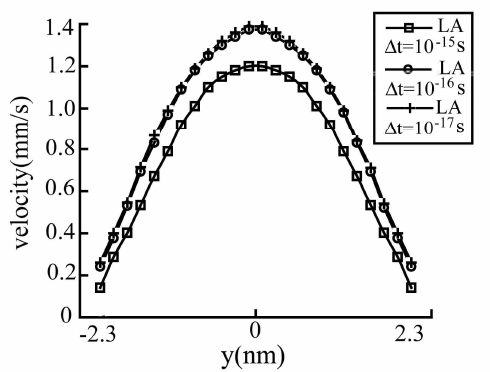
Figure 6 . Comparison of simulation results with different ∆ t (LA Method). Low flow velocity simulations of case 2. The vertical coordinate is the flow velocity and the horizontal coordinate is the height of the channel.